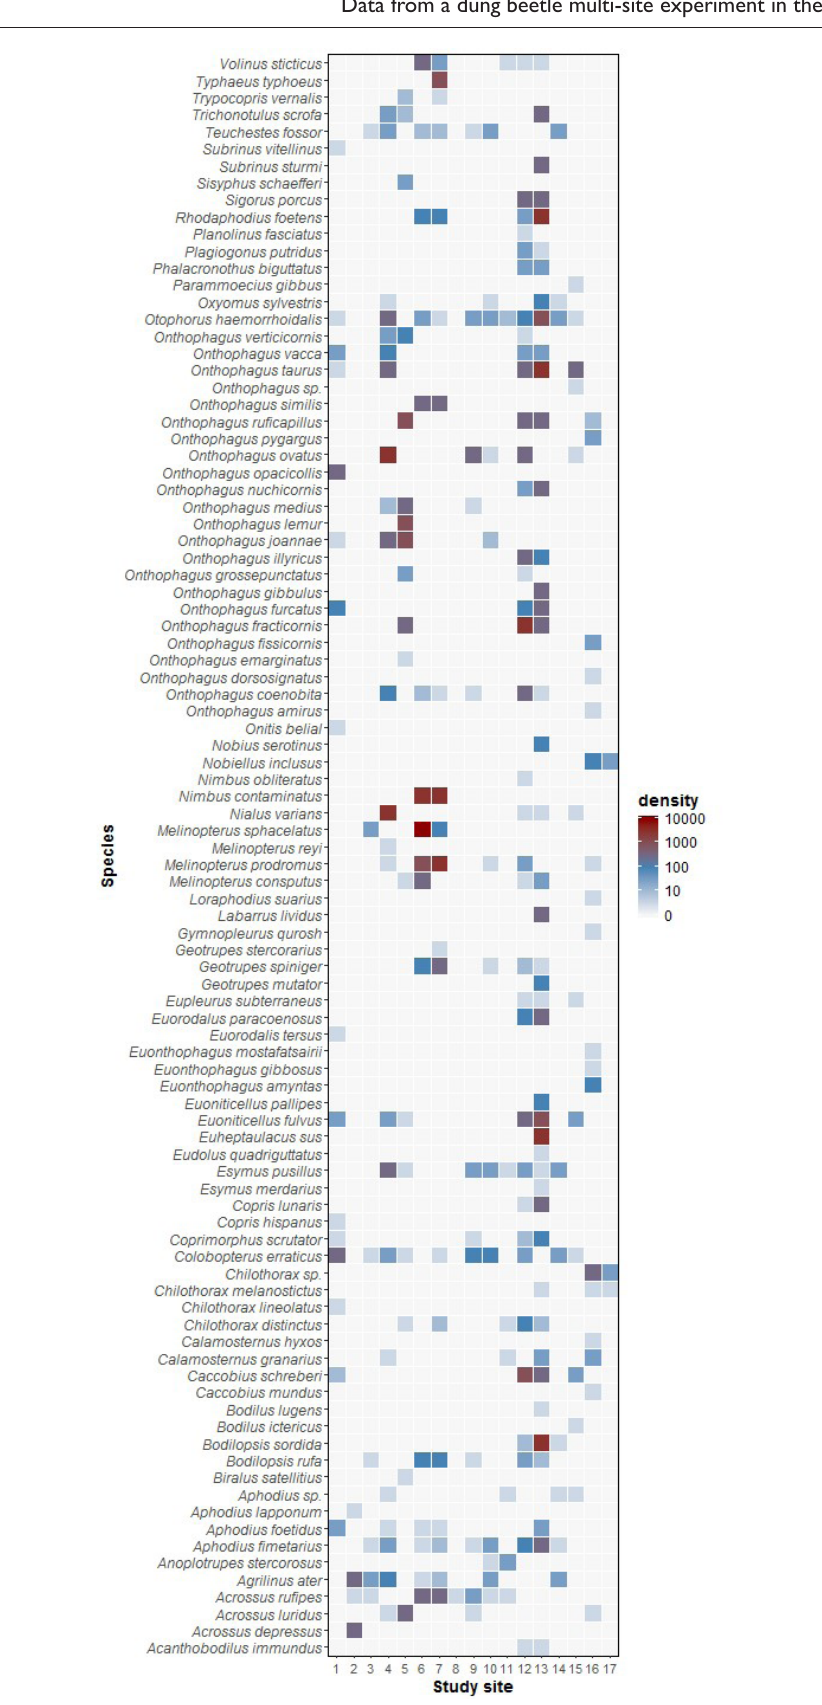
Figure 6. Heat plot of the species found in each study site. Colours indicate the total number of specimens collected of each species (density). Codes of study sites correspond with those in the map of Figure